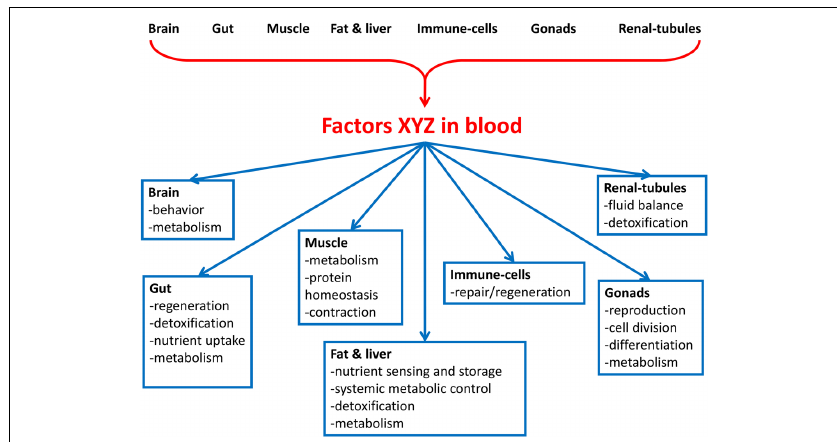
FIGURE 1 | Overview of the interorgan communication network (ICN). The ICN is the network of peptides, proteins, and metabolites that act between organs to coordinate organismal cellular processes under homeostasis and stress. Organs in the body secrete factors that act to influence the physiology of cells in distal organs. Processes that may be connected between organs include aging, protein homeostasis, nutrient uptake, metabolism, cell division, cell movement, detoxification, organelle biogenesis, and secretion of local and systemic signals. The signals may be nutrients, wastes, toxins, metabolites, nucleic acids, proteins, and peptides.